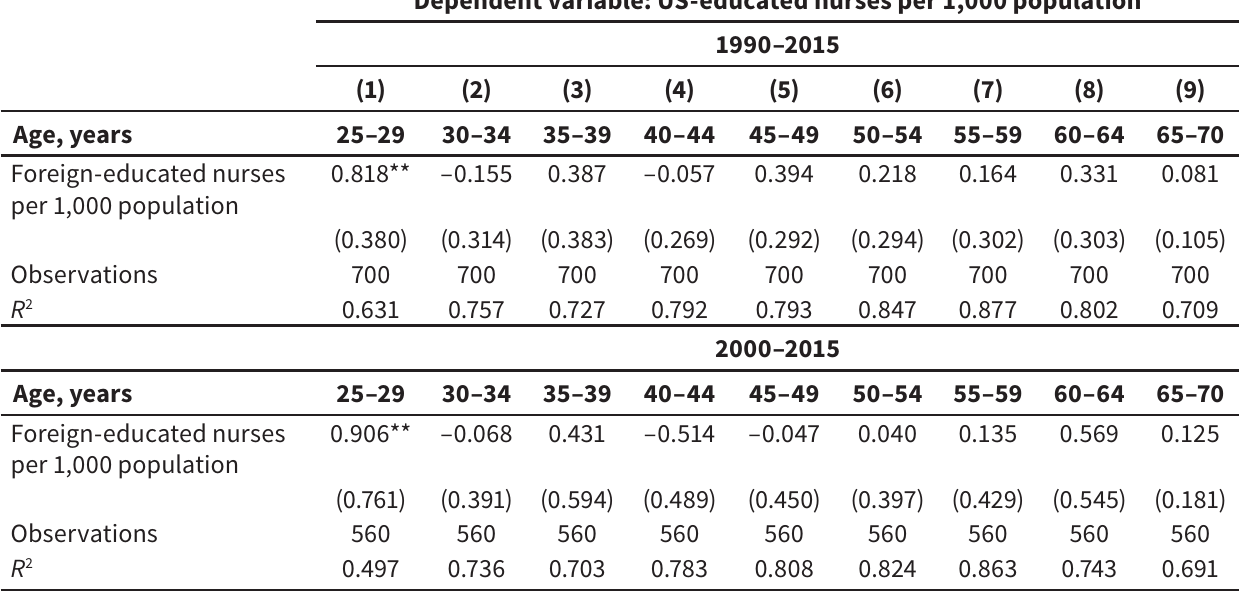
Displacement effects of foreign-educated RNs on US-trained RNs by age Dependent variable: US-educated nurses per 1,000 population